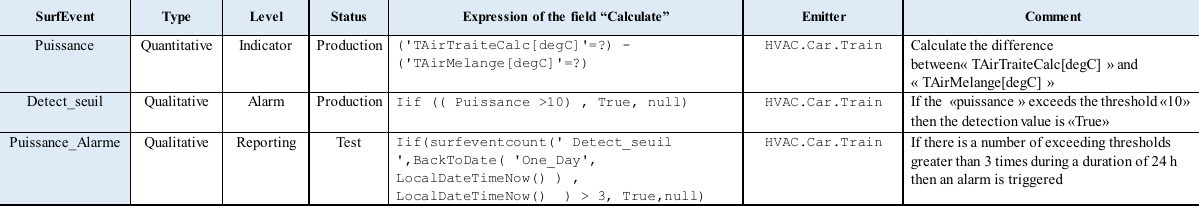
Fig. 14 Formal sample of the holon knowledge base using the type-2 grammar ( surfeventcount: A function that counts the number of occurrences of a SurfEvent between two dates. BackToDate : A function that returns the time period between two dates. Iif(Exp, TruePart, FalsePart): A function that returns either TruePart or FalsePart, depending on the evaluation of the Boolean Expression